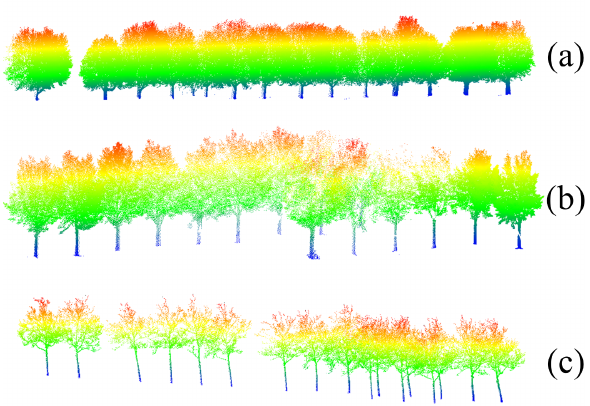
Figure 6: Three species of trees are studied in this work.